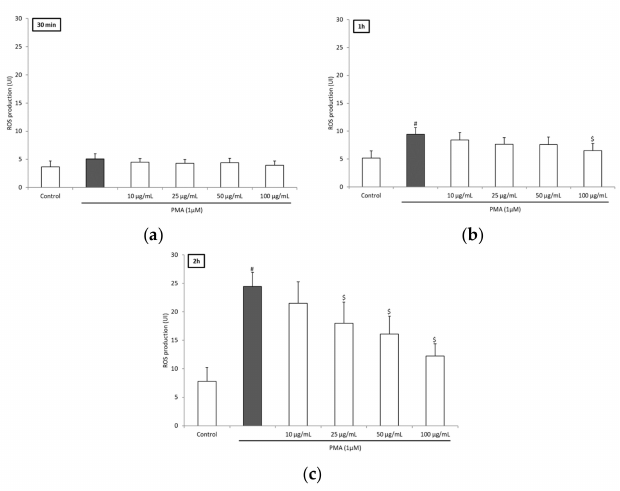
Figure 1. BRE concentration dependently inhibited ROS production of blood leukocytes. Cells were incubated with BRE (0, 10, 25, 50, and 100 µ g / mL) and stimulated with PMA (1 µ M) for ( a ) 30 min; ( b ) 1 h; and ( c ) 2 h. Data were shown as means ± SD; # p < 0.05 compared with Control, $ p < 0.05 compared with PMA-stimulated cells (0 µ g / mL BRE). BRE: Bupleurum